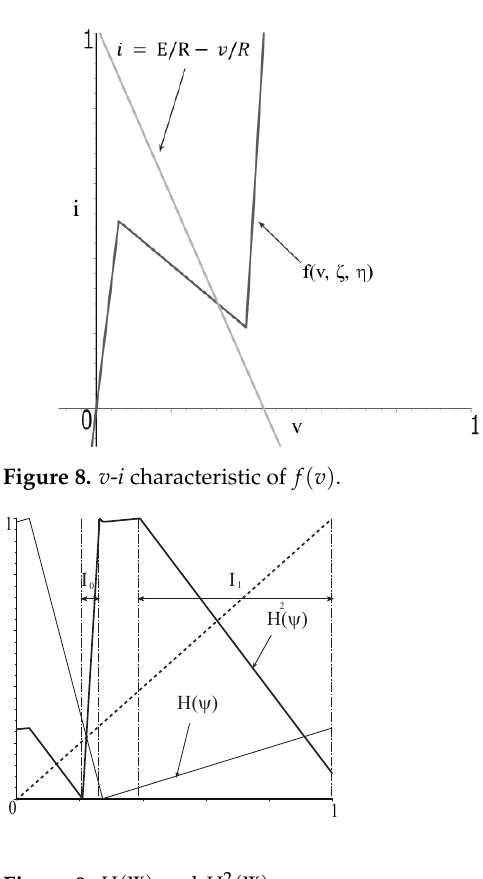
Figure 9. H ( Ψ ) and H 2 ( Ψ )